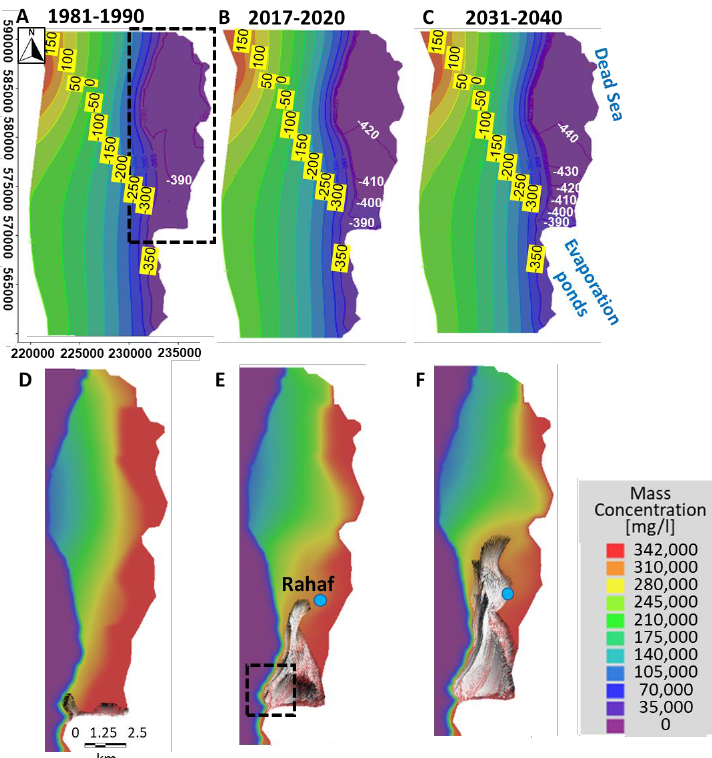
Figure 10. Maps of groundwater level (meters above sea level, ( A – C ) and salinity distributions ( D – F ) for three period steps: first, present and future. The head contour difference is 50 m in general (values on yellow background) but 10 m between the ponds and the lake, where the increasing gradient with time is notable (values in white). Note the difference in the high salinity between ( D – F ) indicating brine washing with time on the newly exposed land. In ( D – F ), The black–white lines are particle tracking of brine leakage from the pond’s northern embankment progressing toward the Rahaf borehole (location is shown in ( E , F )). The dashed rectangular area on map A represents the area that is enlarged in maps ( D – F ). The dashed rectangular area on map E is the area shown in Figure 11.